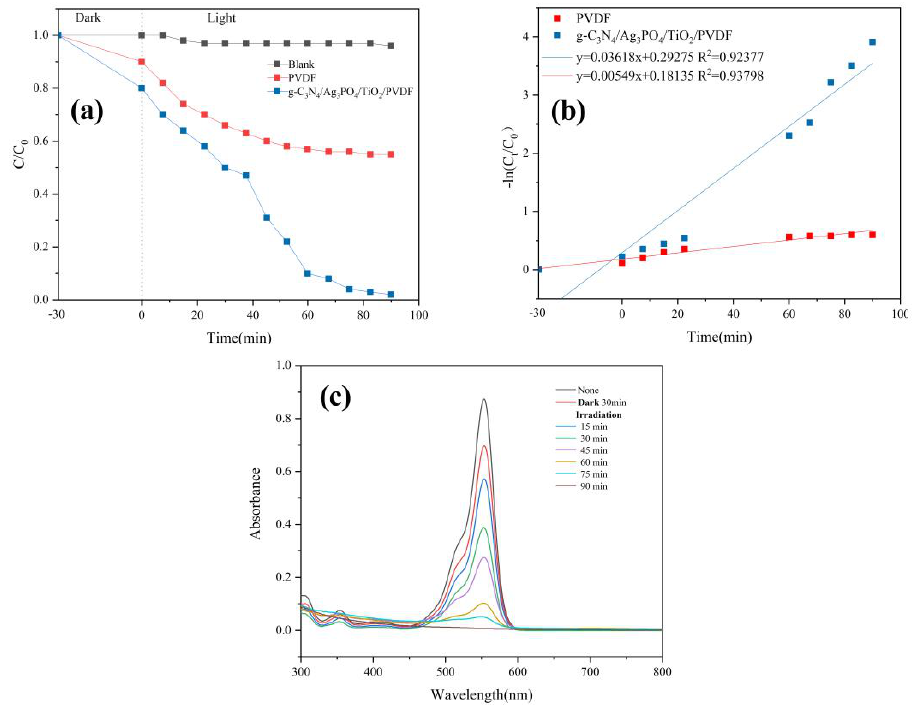
Figure 9. ( a ) Membrane performance for the photocatalytic degradation of RhB, ( b ) kinetic model for the photocatalytic degradation of RhB, and ( c ) changes in the UV–Vis spectra of RhB with reaction time (initial RhB concentration of 10 mg/L, pH = 6.4).